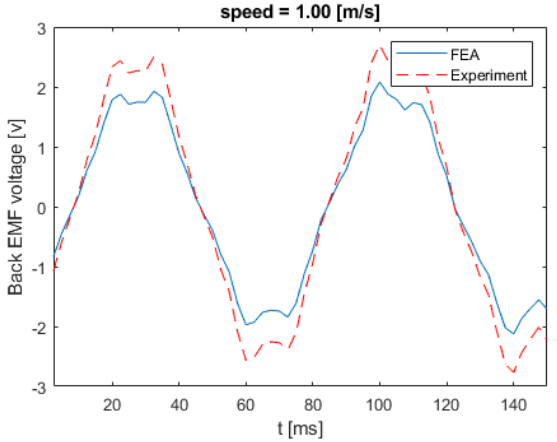
Figure 19. Back EMF voltage for linear speed of 0.74 m/s.